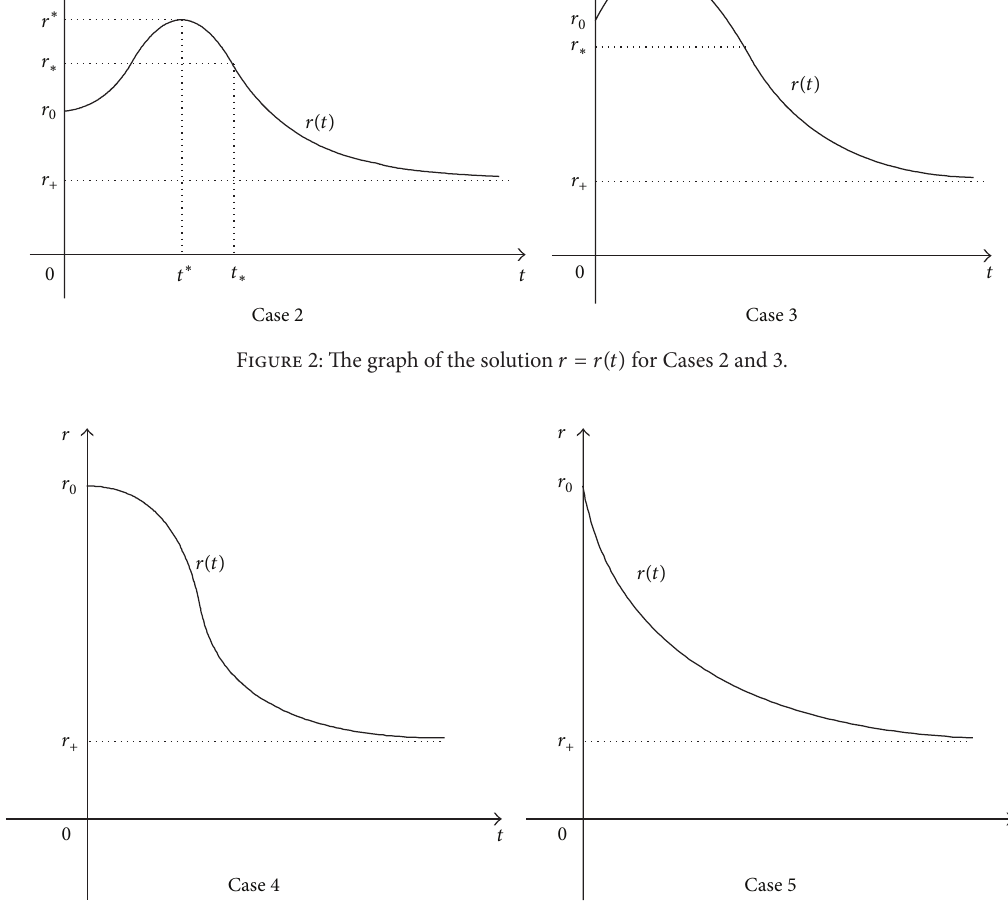
Figure 3: The graph of the solution 𝑟 = 𝑟(𝑡) for Cases 4 and